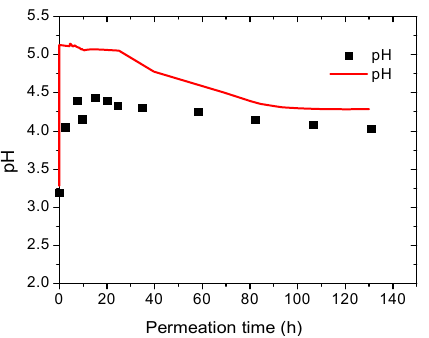
Figure 6. Variations in chemical concentration and solution pH of leachate with permeation time (scatter is test data and curve is simulated results; simulated curve considers effects of cation exchange).